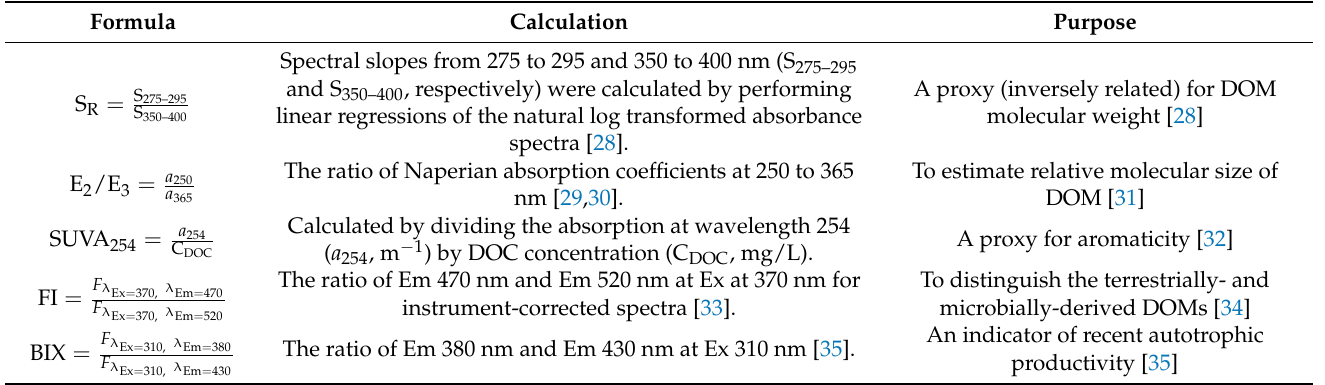
Table 1. Summary of absorption and fluorescence